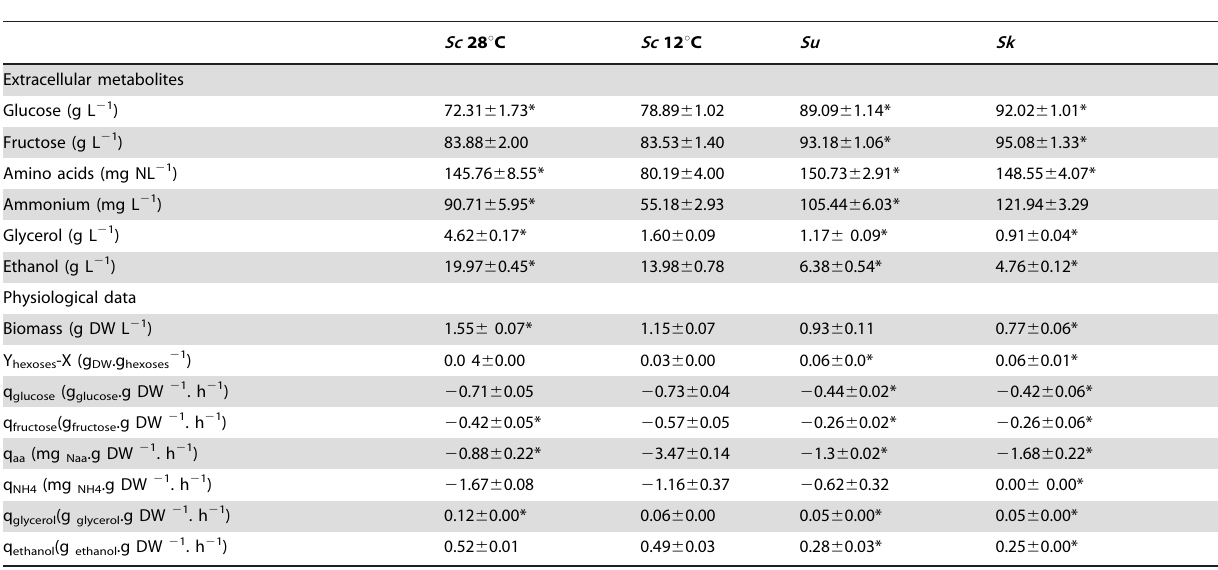
Table 1. Physiological characteristics of Saccharomyces strains and extracellular metabolites during the steady state of continuous